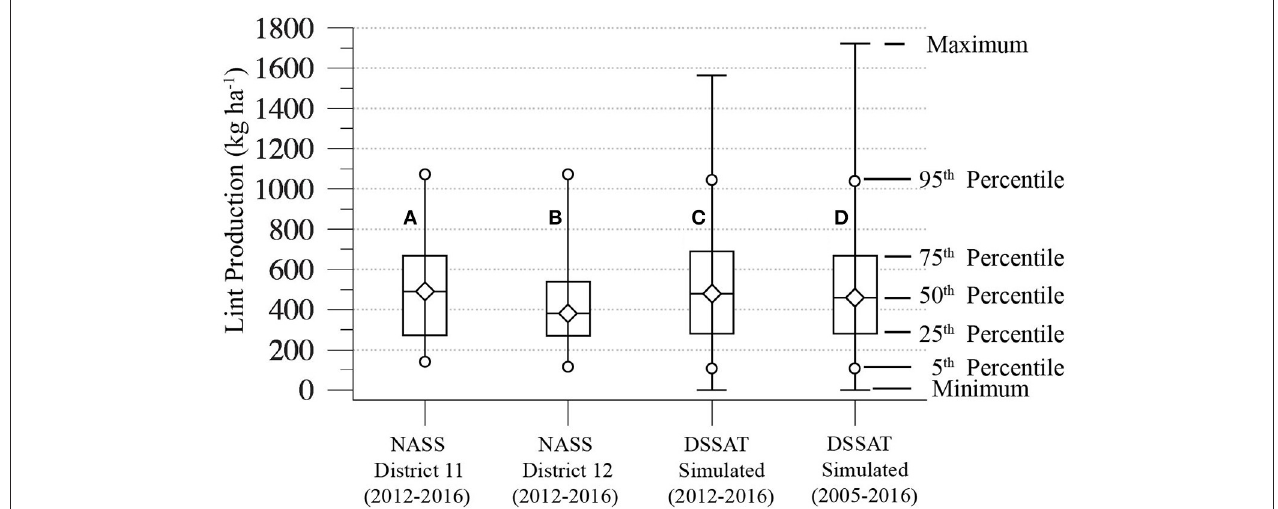
FIGURE 2 | (A) Percentiles of lint yields derived from NASS District 11 un-irrigated yield reports during the 2012–2016 cropping years. (B) As in (A) for NASS District 12 yield reports. (C) Percentiles of modeled lint yields aggregated from CROPGRO-Cotton simulations conducted at 21 locations and 32 management options during 2012–2016 (21*32*5 = 3,360 yields). (D) As in (C) for modeled yields aggregated over the 11 years of 2005–2010 and 2012–2016 (21*32*11 = 7,392